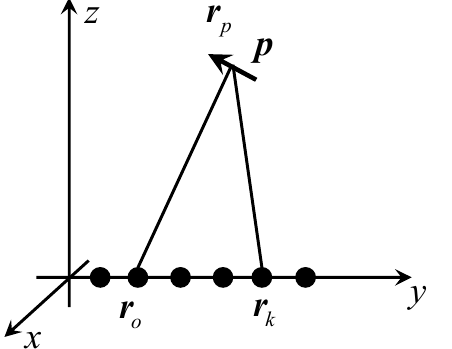
Figure 1. Schematic of the three-dimensional electric field-based multi-electrode underwater